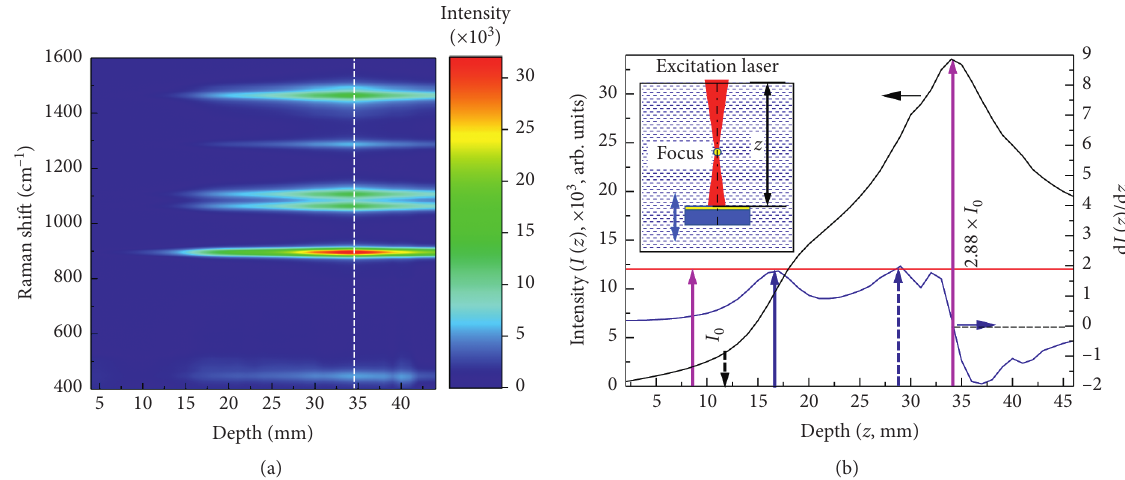
Figure 3: (a) The Raman signal intensity as a function of Raman shift and the location depth of the flat feedback mirror underneath the liquid surface. (b) The Raman signal peak intensity I(z) at 895cm − 1 at different depths ( z ) of the flat optical feedback mirror. Blue curve: calculation of dI(z)/d(z) . Inset: schematic illustration of the measurement